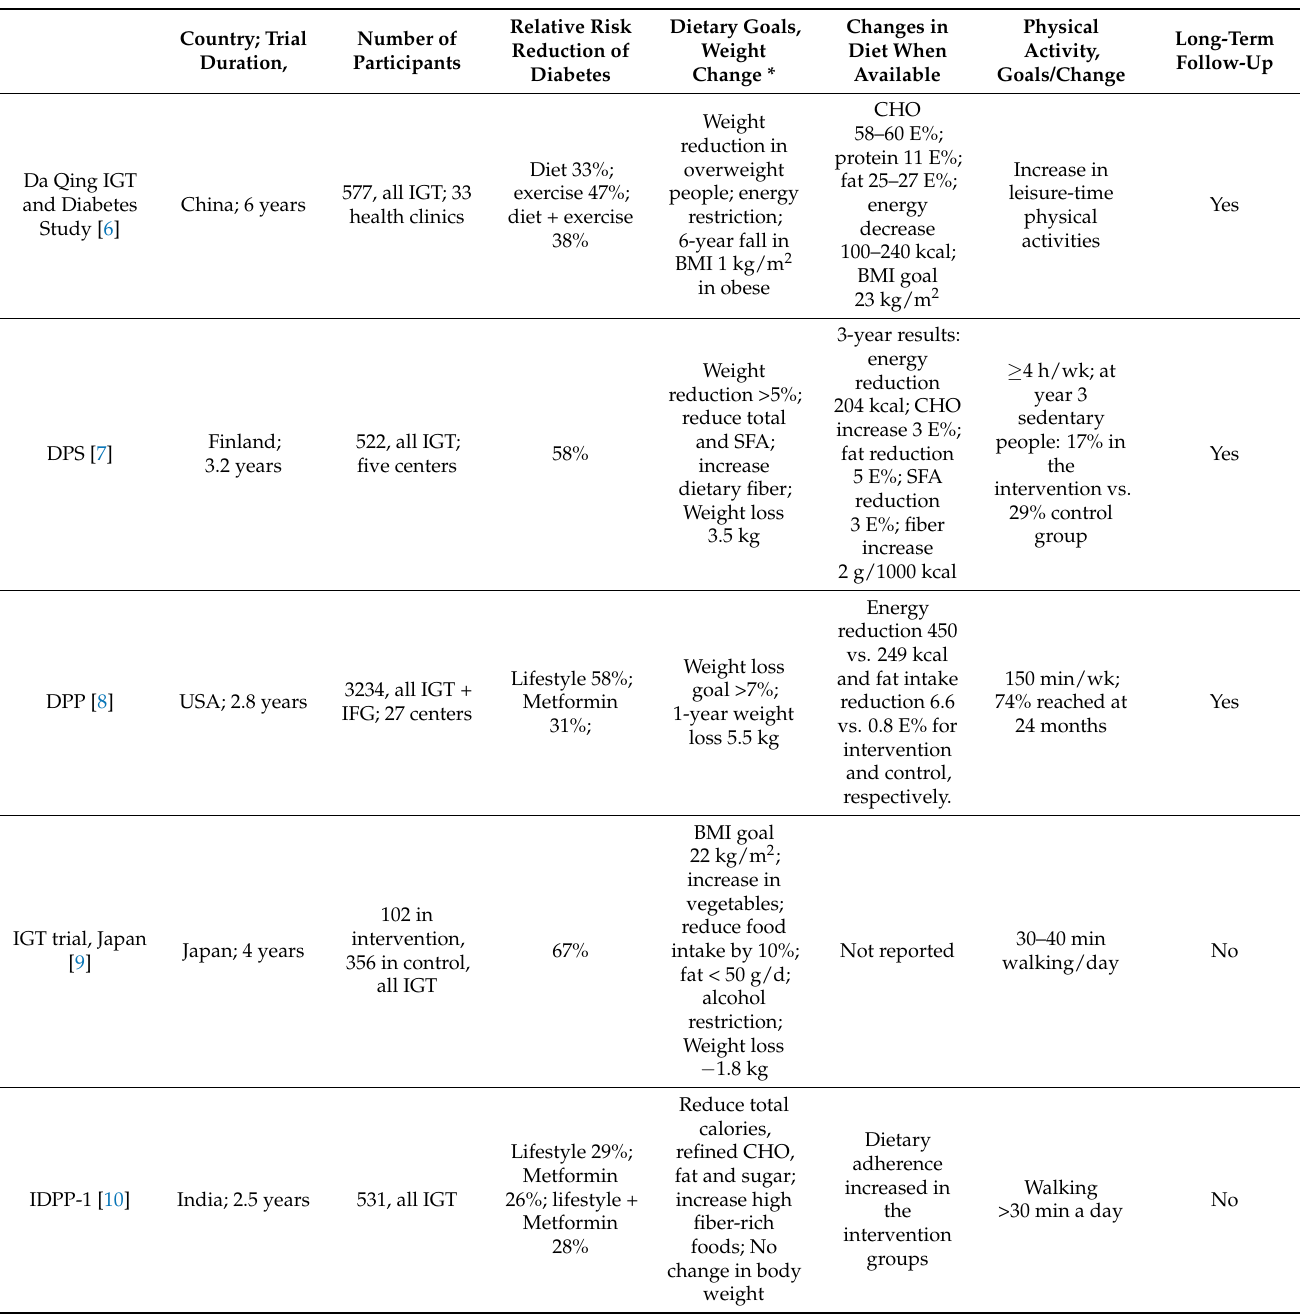
Table 1. Summary of the proof-of-concept trials aimed at preventing the progression to type 2 diabetes in people with impaired glucose